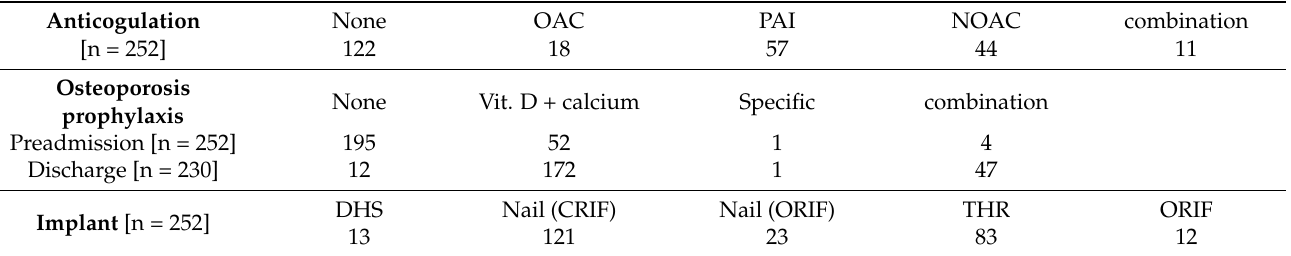
Table 3. Details of risk factors included in the statistical